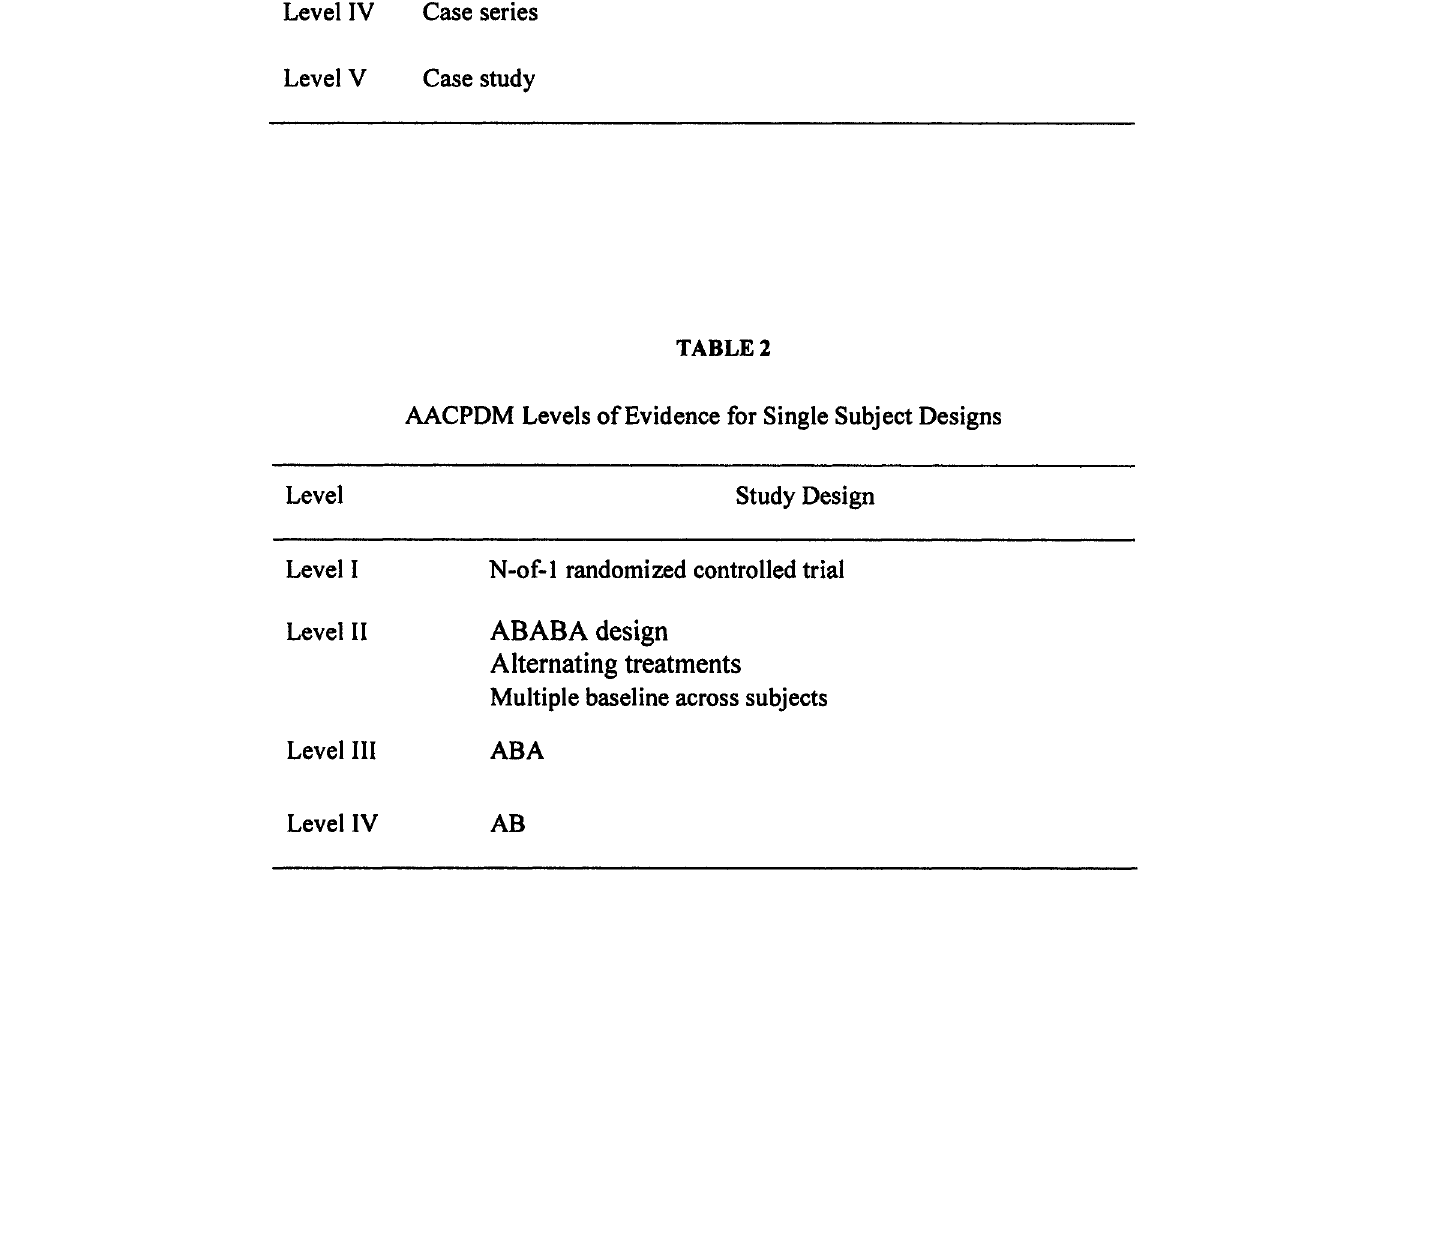
AACPDM Levels of Evidence for Single Subject